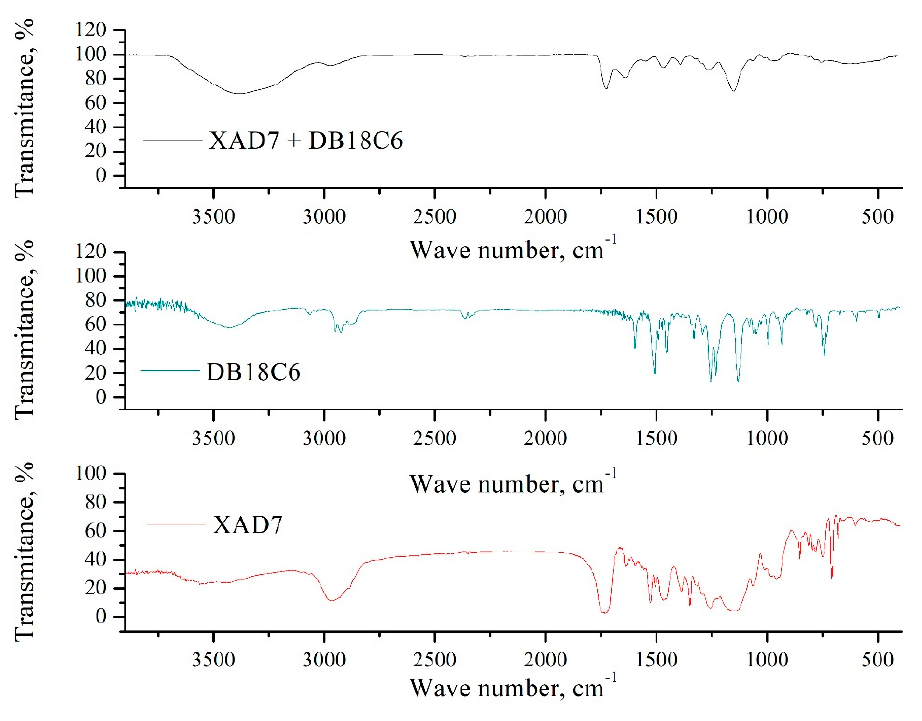
Figure 3. FT-IR spectra recorded for Amberlite XAD7 and Amberlite XAD7-DB18C6.